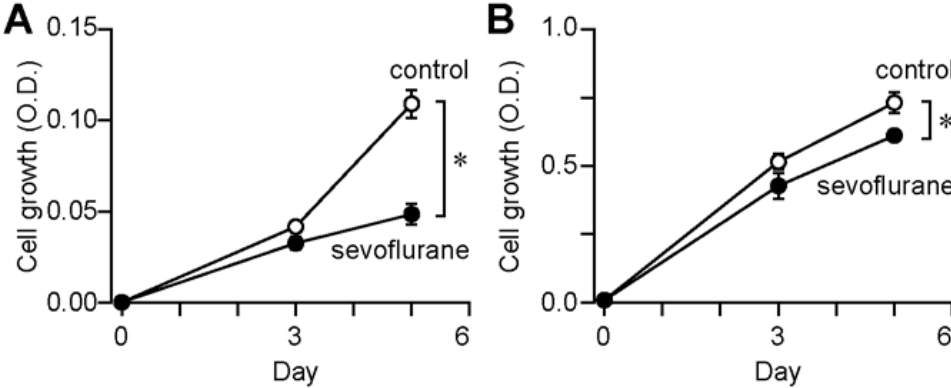
Figure 2. Cell proliferation assay. Growth of ( A ) MD13 and ( B ) Me83 cells. Data are presented as mean ± SD ( n = 6). Differences between groups were evaluated using one-way analysis of variance. * p < 0.05, as compared with the value at 5 days.